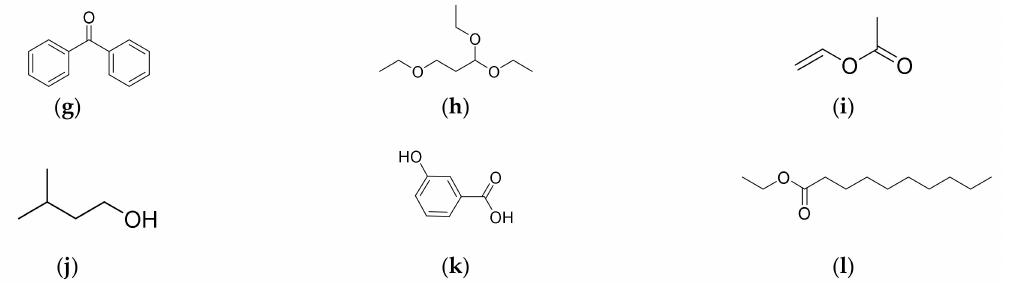
Figure 2. Main chemical compounds identified in the HELTr by GC-MS through TIC, NITS/MS